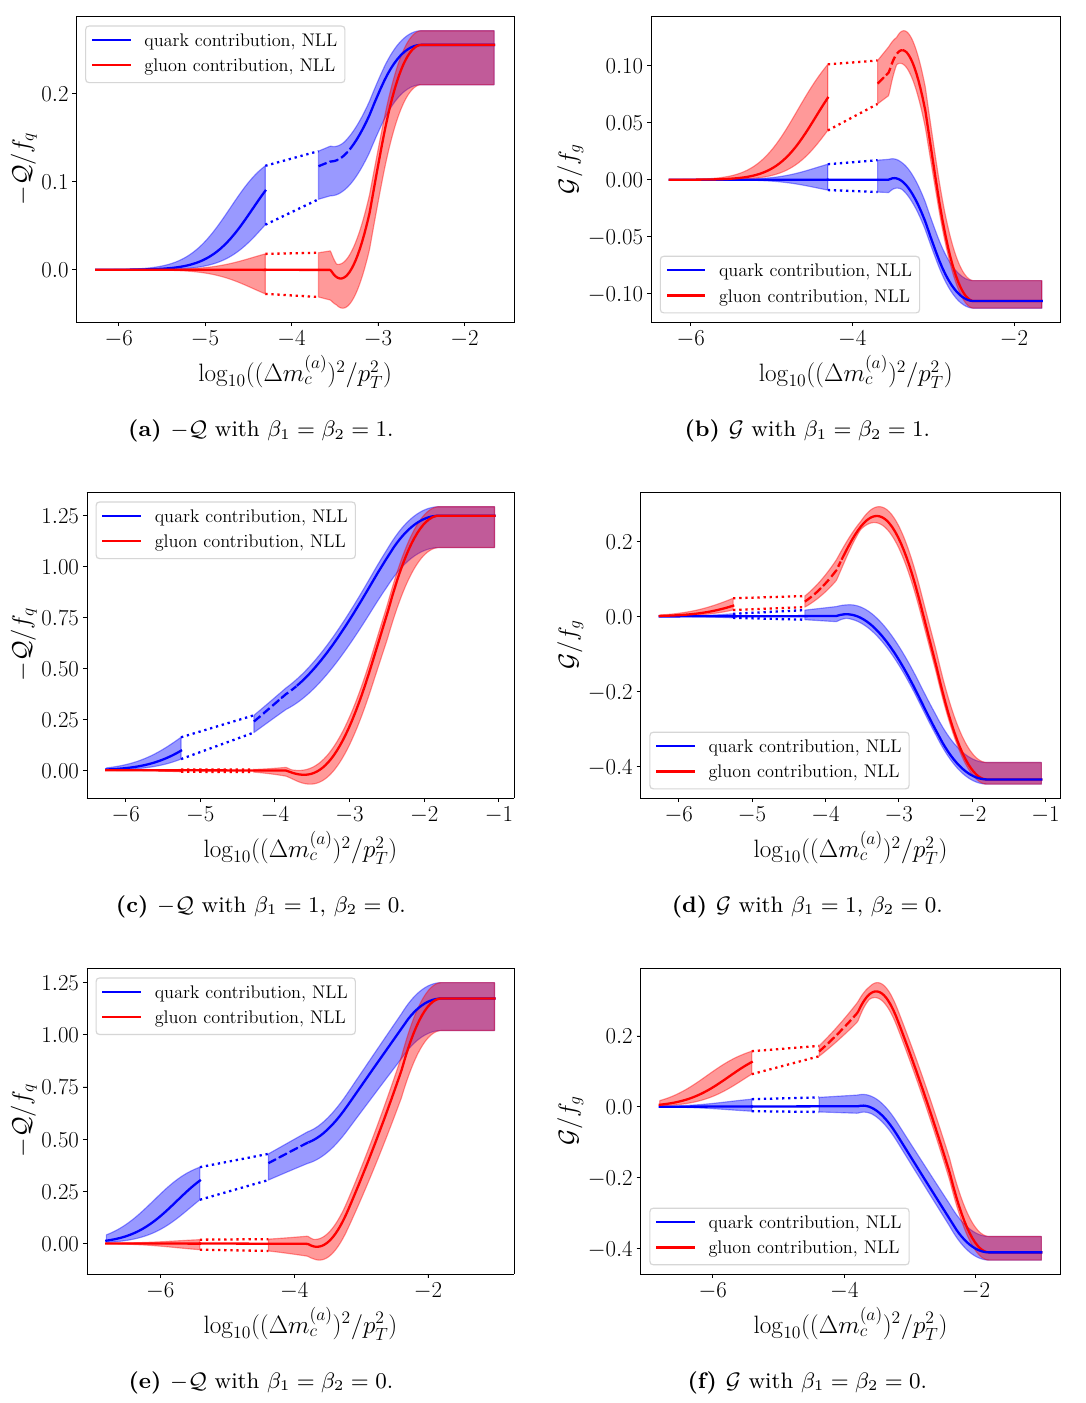
Figure 8. Pure quark (left column) and gluon (right column) observables with the shape functions included for cases with β 1 = β 2 = 1 (upper row), β 1 = 1 , β 2 = 0 (middle row) and β 1 = β 2 = 0 (lower row) in the full jet mass region. Only the results in the deep nonperturbative regime and in the fully perturbative regime are shown. The results in the transition region are omitted here. The uncertainty bands include uncertainties from the observable definition, the perturbative calculation and the shape